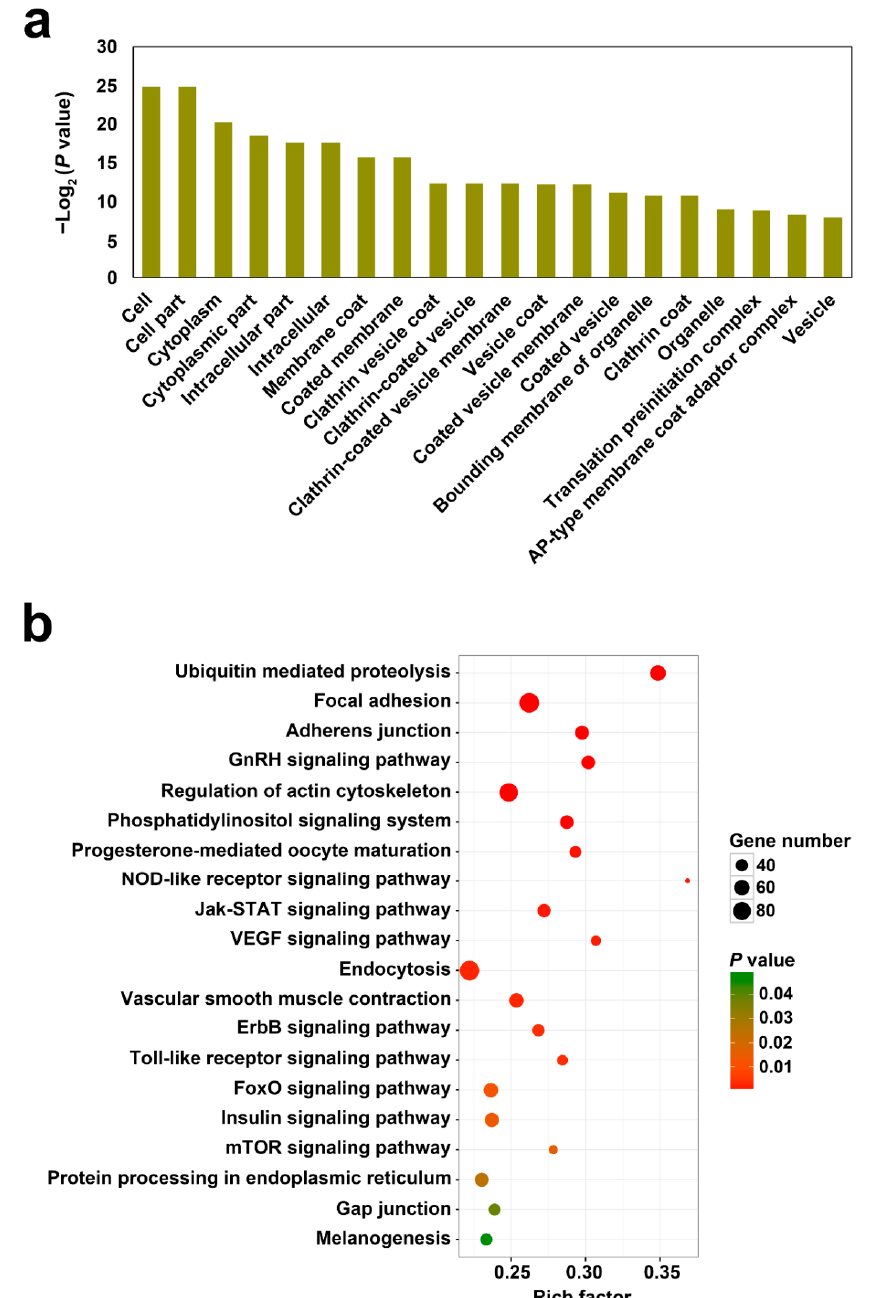
Figure 2. GO ( a ) and KEGG ( b ) functional enrichment of the parental genes of the identified circRNAs in Japanese flounder.